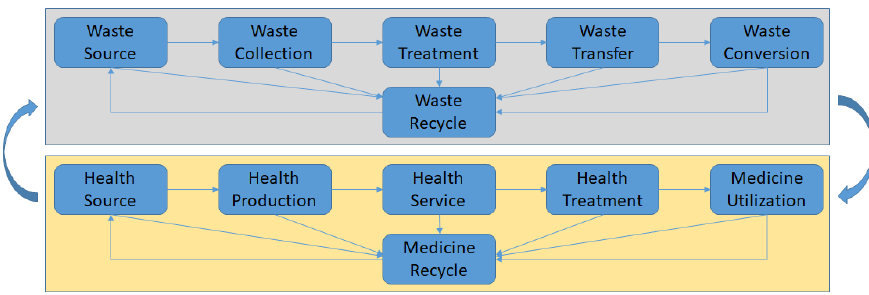
Figure 4. Proposed modeling of hybrid health–waste interconnected systems.